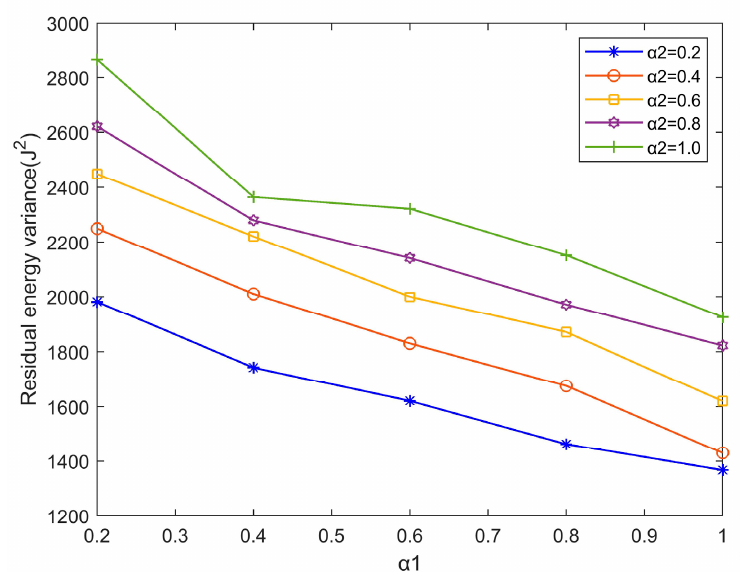
Figure 4. Residual energy variance of α 1 and α 2 (CR = 1000 m).